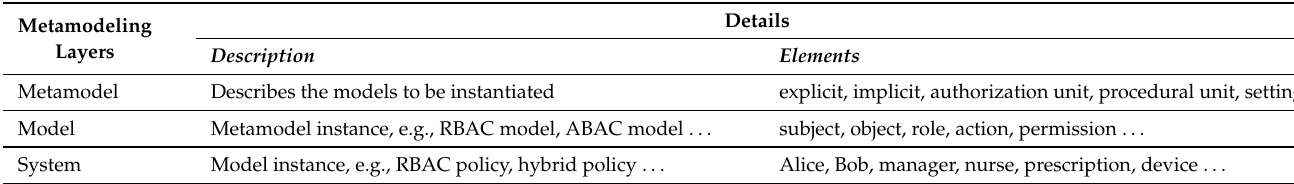
Table 1. Metamodeling layers and